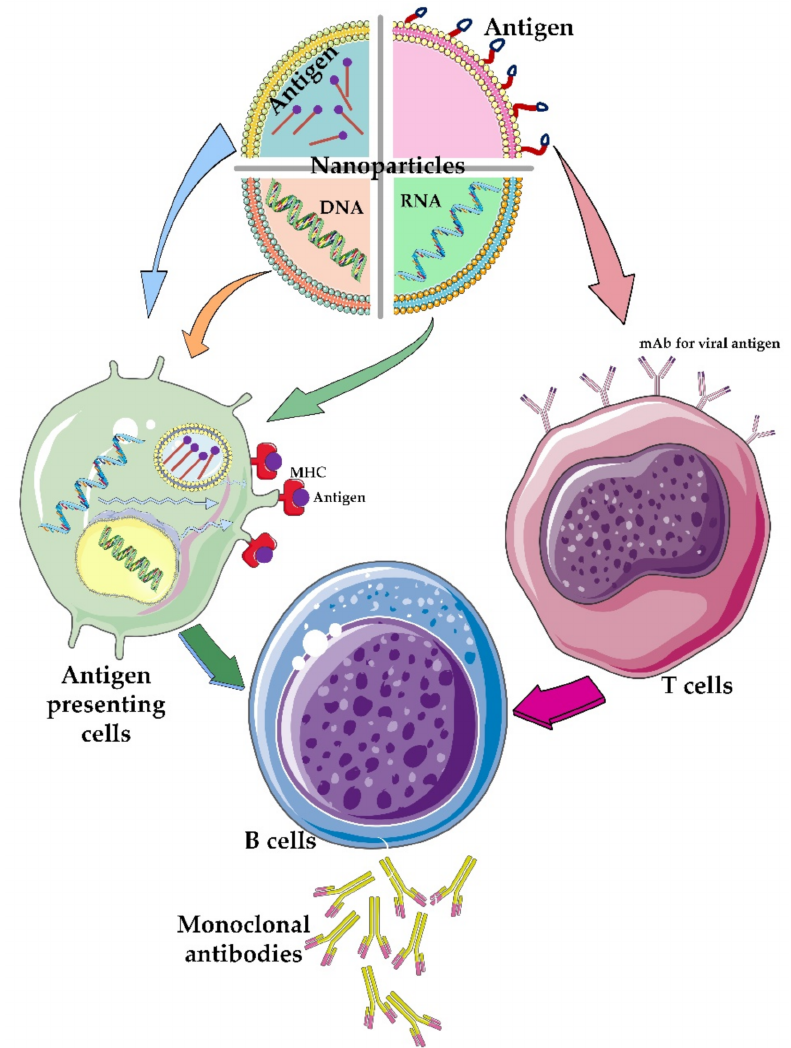
Figure 5. The role of different nanoparticles containing therapeutic agents. Different nanoparticles have been used to carry different components of viral particles such as genetic material and/or its antigens. The viral genetic materials are usually encapsulated or trapped inside the nanoparticles while the viral antigens are functionalized on the surface of the nanoparticles. Depending on which type of T-cell or antigen-presenting cells these engineered nanoparticles attach to, different immunological pathways are created in the body, which ultimately lead to the activation of B cells that produce monoclonal antibodies against the virus